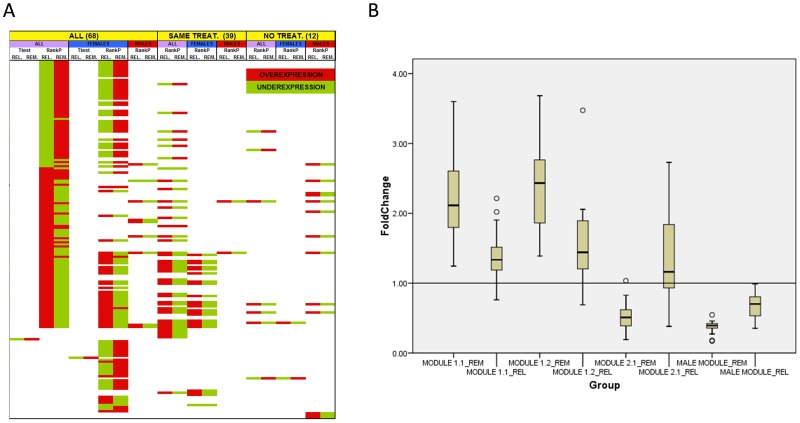
Graphical representation of the “mirror pattern” of the genes altered both in relapse and remission.
A: direction of the alteration (over/underexpression) of the 174 differentially expressed genes in the different comparisons. REL: relapse vs. remission; REM: remission vs. controls. B: box-plot representation of the fold-change values vs. controls in remission and relapse for each of the four main modules of the coexpression network. _REM: remission vs. controls; _REL: relapse vs. controls.